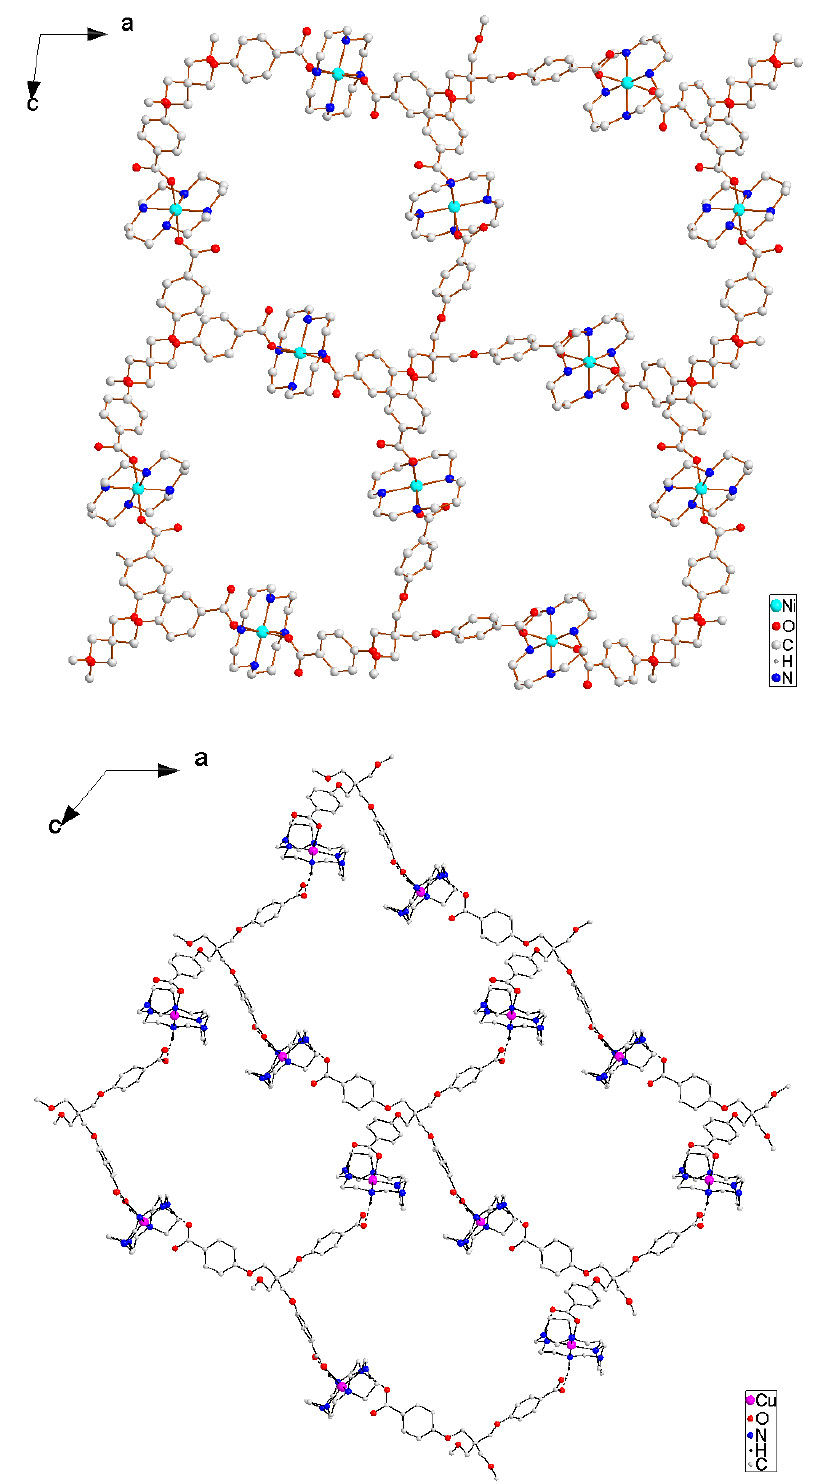
Figure 7. View along b axis of an adamantoid cage fragment from the 3D network in the crystal of [Ni(cyclam)] and